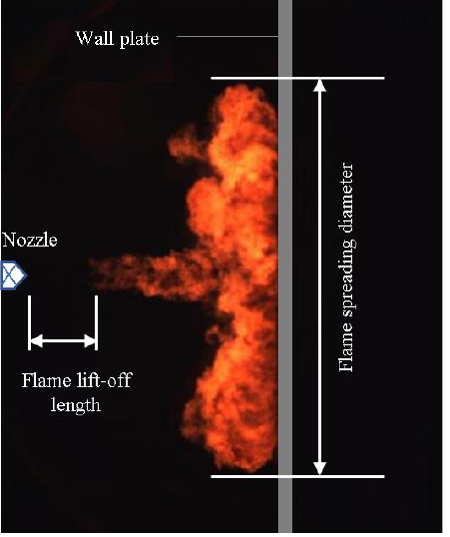
Figure 12. Geometric information of the flame.